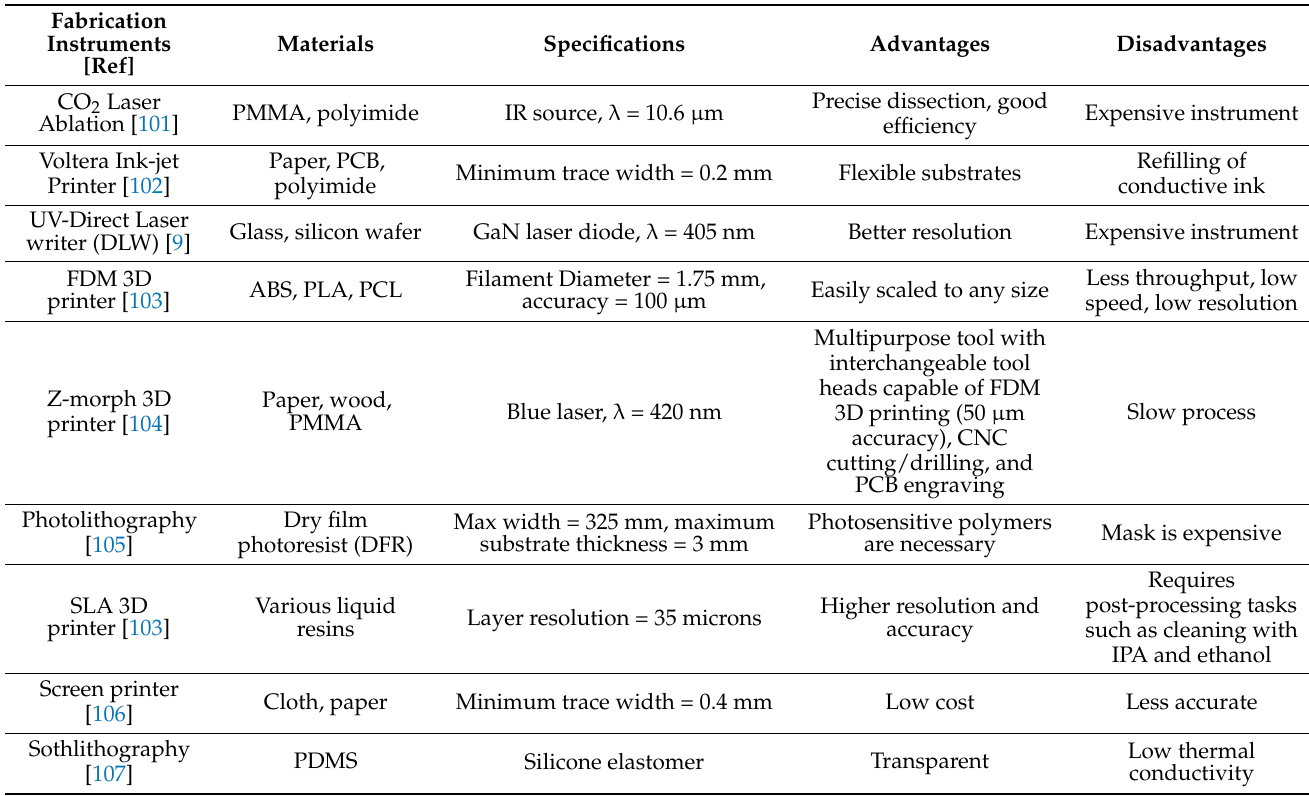
Table 5. List of various microfabrication techniques used in the development of miniaturized microfluidic biosensors.